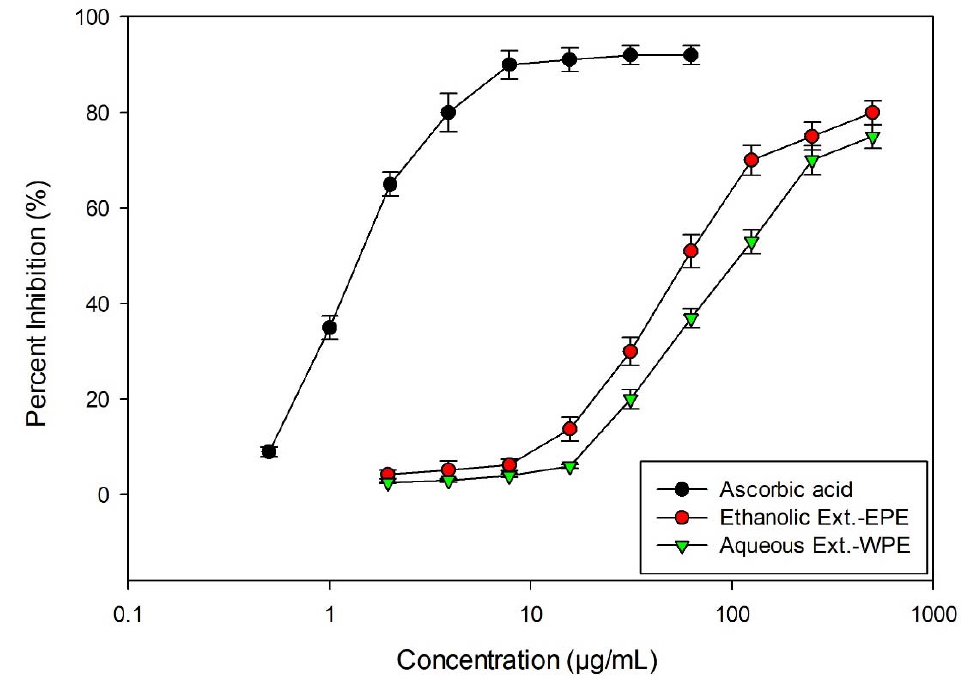
Figure 6. DPPH radical scavenging activity of ascorbic acid (standard), EPE and WPE. Plot showing concentration versus percentage inhibition.